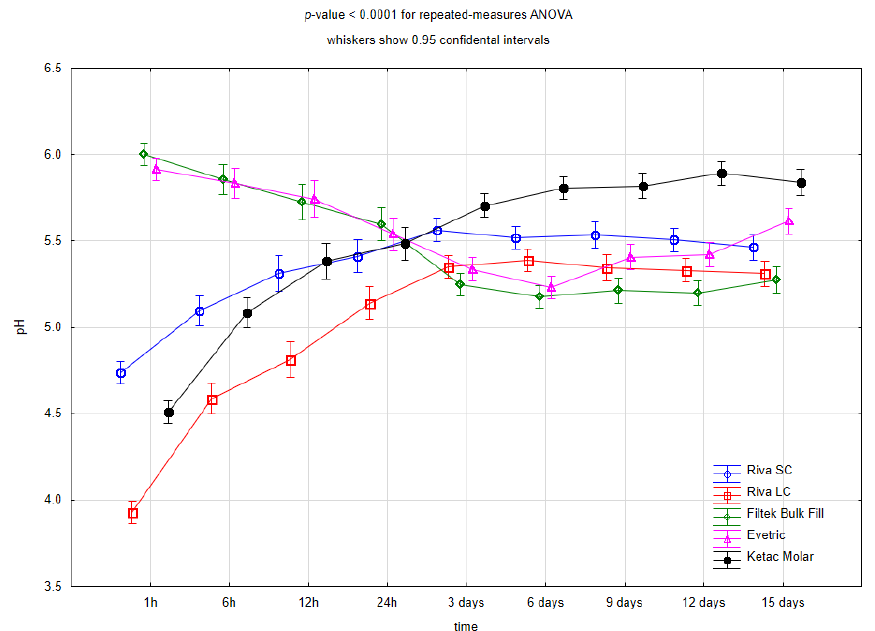
Figure 1. Repeated-measures analysis of variance for pH values in the individual time points depending on the dental restorative material (without subdividing by number of samples).